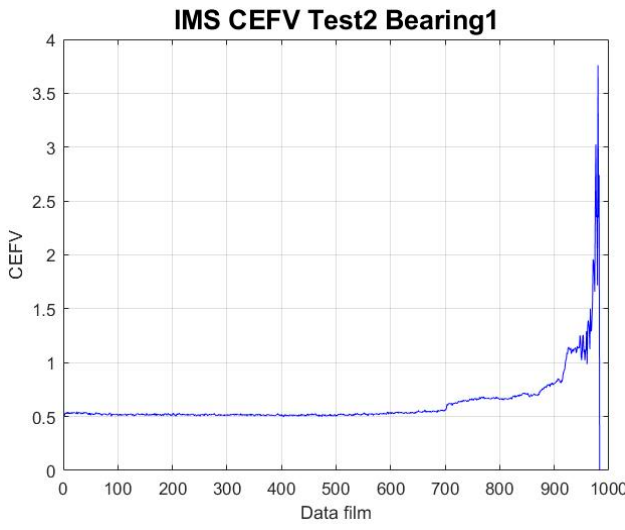
Figure 3. IMS data’s CEFV HI values.